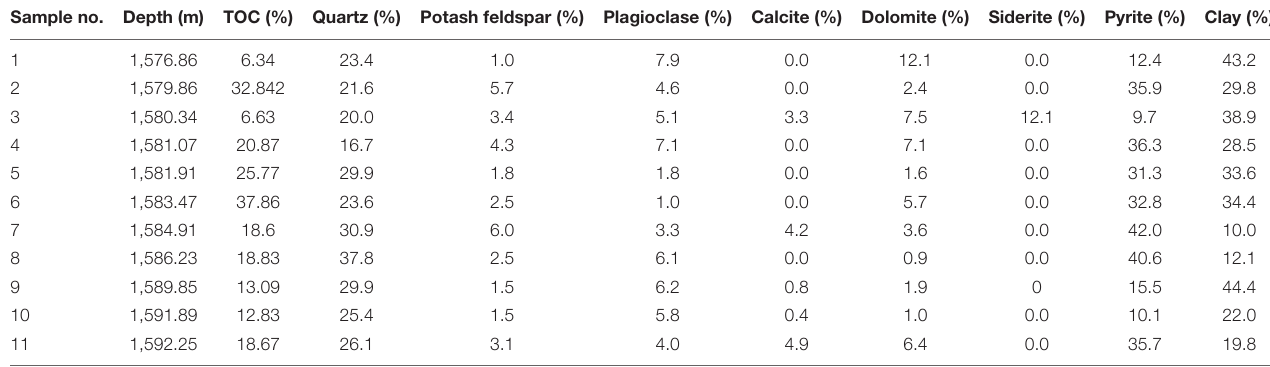
TABLE 1 | Basic geochemical data of the experiment samples.